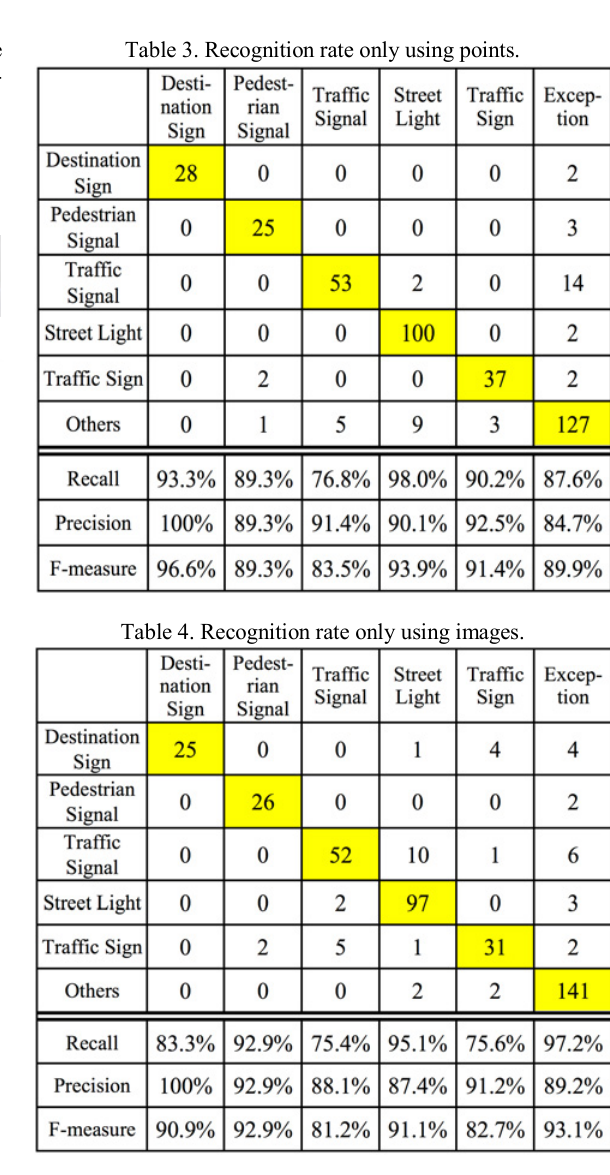
Table 5. Recognition rate using points and